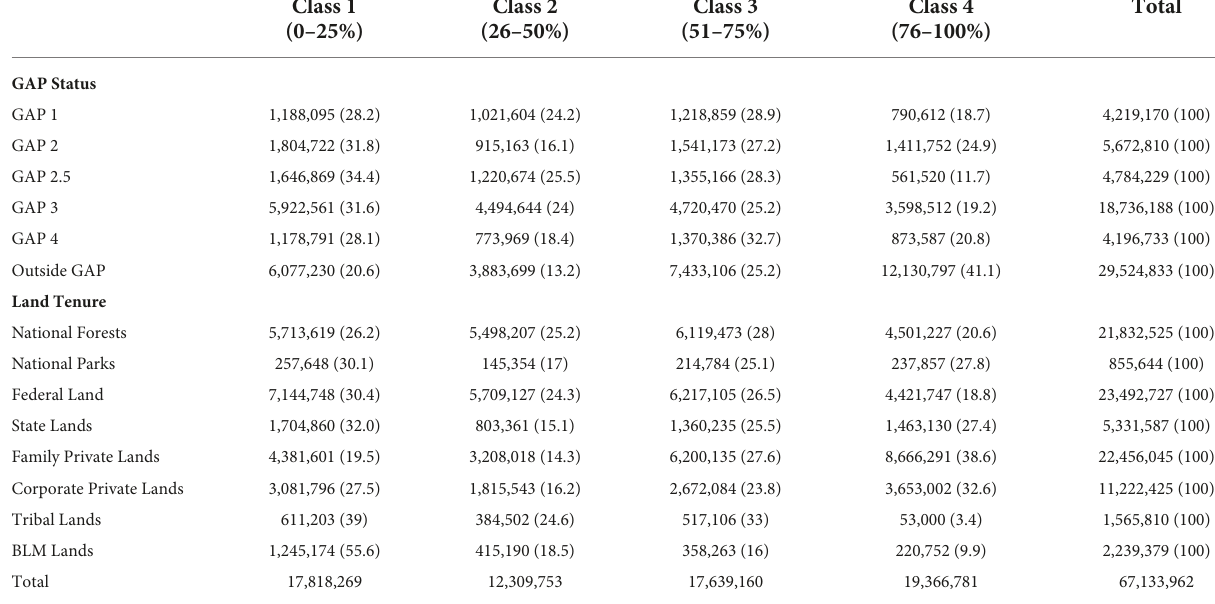
TABLE 7 Mature forest area (ha) in each relative importance to surface drinking water class by GAP status and land tenure, with percentage of total mature and old-growth forest in the respective